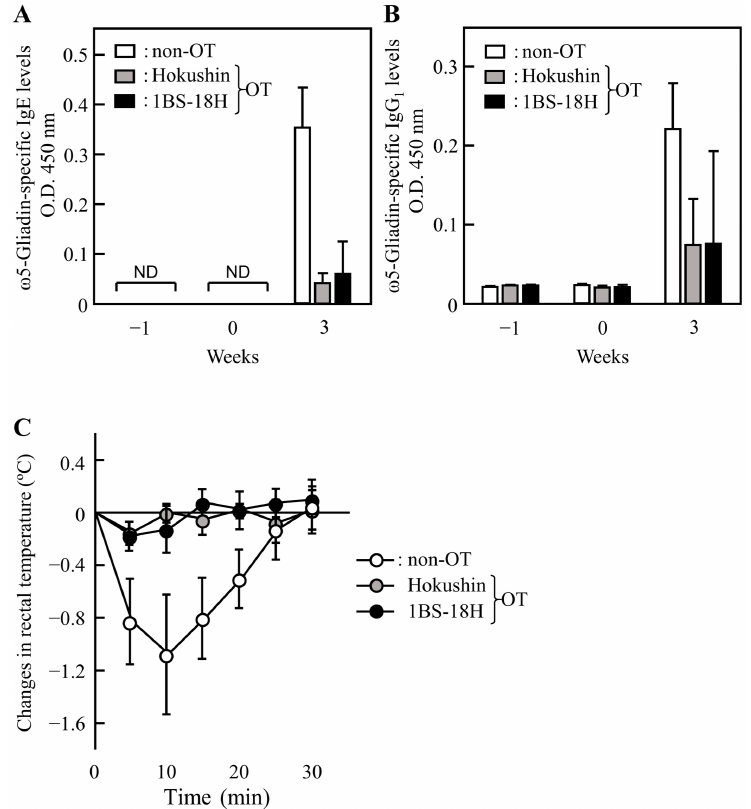
Figure 5. The effects of the oral administration of 1BS-18H gluten on the induction of oral tolerance (OT) to gluten in ω 5-gliadin-immunized rats. The levels of IgE ( A ) and IgG 1 ( B ) Abs specific for ω 5-gliadin in plasma were determined at weeks − 1, 0, and 3 in rats immunized subcutaneously with ω 5-gliadin (weeks 0 and 2) following the oral administration of vehicle alone (50% ethanol, non-OT), gluten from Hokushin (10 mg, Hokushin), or gluten from 1BS-18H (10 mg, 1BS-18H) daily for 5 days. Changes in rectal temperature ( C ) were evaluated after the administration of ω 5-gliadin (2 mg/kg) intravenously at week 3. Each value represents the mean ± SD of four rats. ND, not